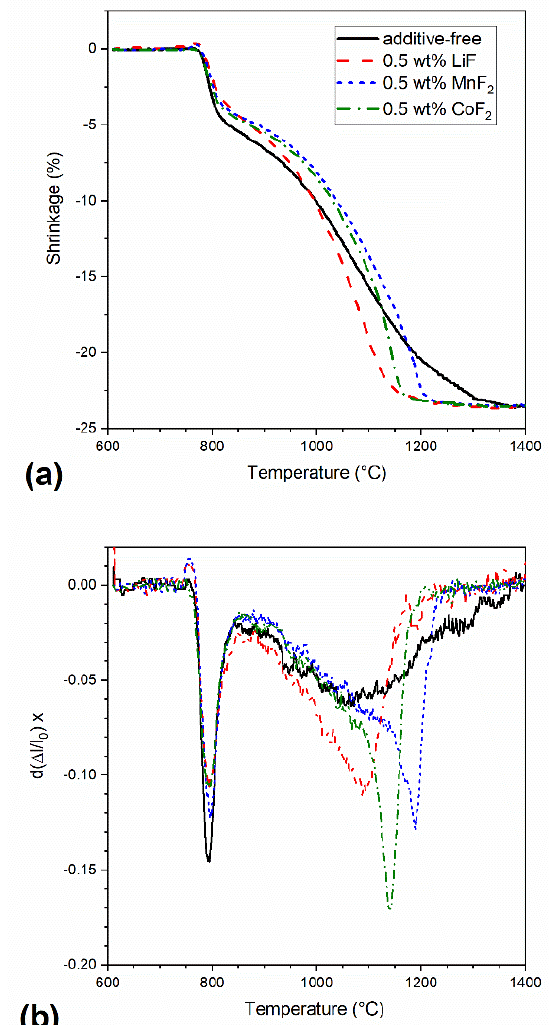
Figure 2. ( a ) Relative shrinkage of additive-free spinel and spinels doped with LiF, MnF 2 , and CoF 2 (0.5 wt%) with temperature and ( b ) first derivative of the shrinkage calculated using Equation (1).